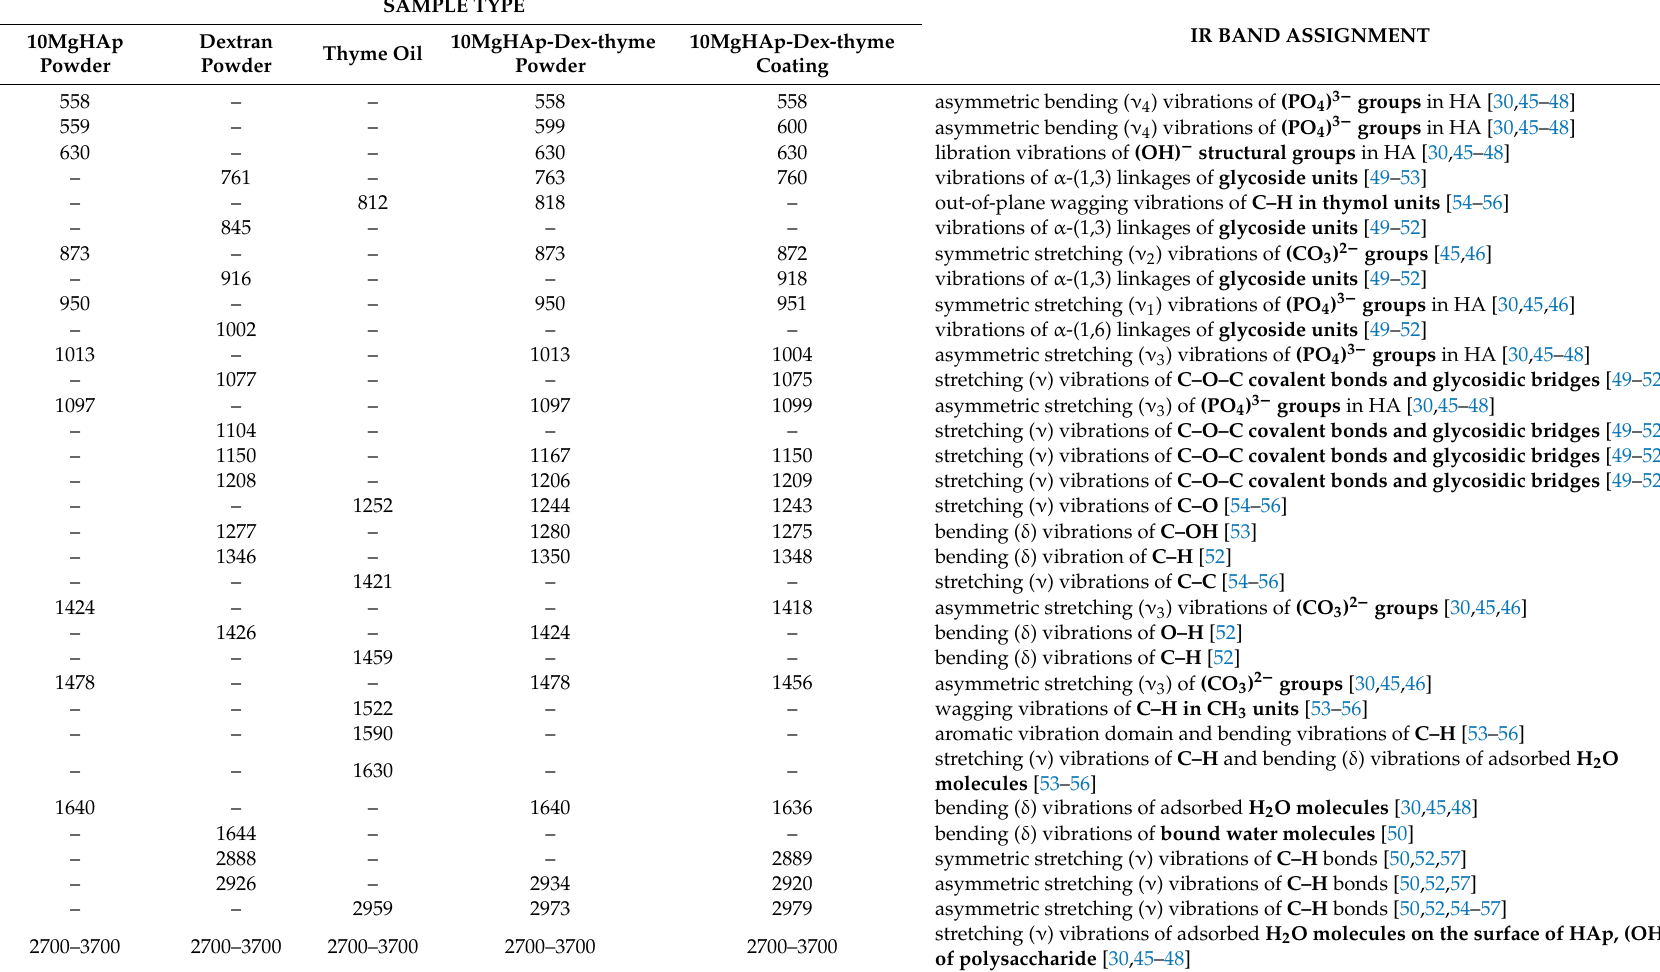
Table 2. Assignment of the FTIR-ATR spectroscopy vibration